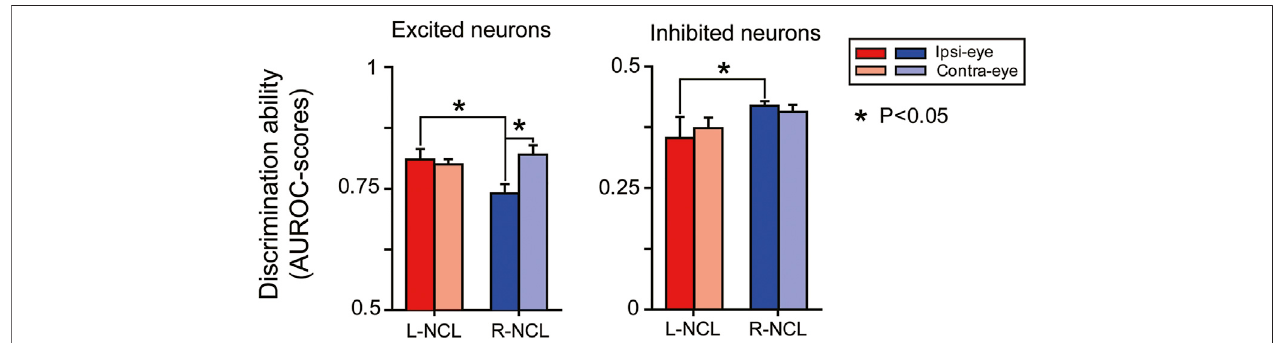
FIGURE 6 | Discrimination scores (AUROC-value: mean ± SEM) of NCL visuomotor neurons in left (L) or right NCL (R) .